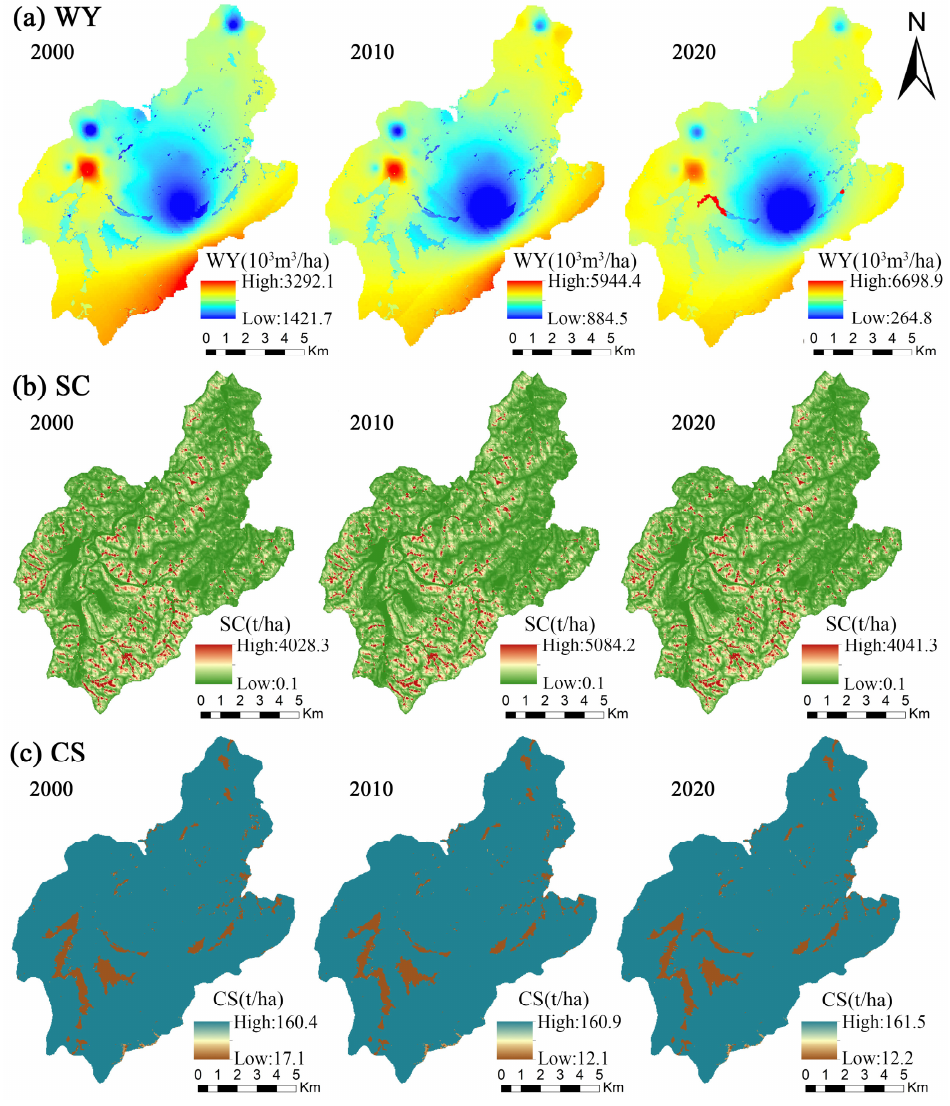
Figure 4. The spatial pattern of ecosystem services in the study area in 2000, 2010, and 2020; ( a ) water yield; ( b ) soil conservation; ( c ) carbon